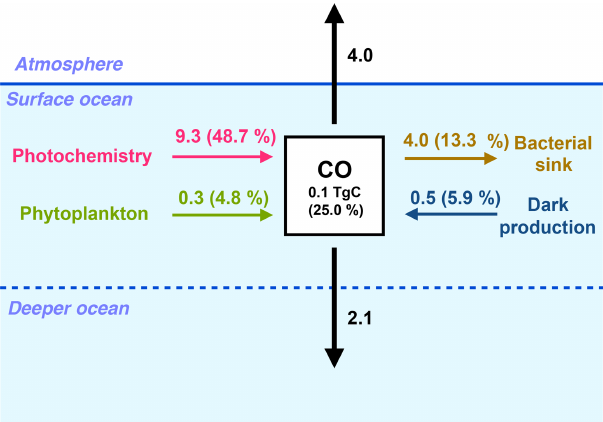
Figure 3. Global fluxes in the surface ocean (between 0 and 10m) of the oceanic CO sources and sinks (in TgCyr − 1 ). For each biogeo- chemical term (photoproduction, direct phytoplankton production, dark production and bacterial consumption), the relative contribu- tion of the surface layer to the whole water column budget is shown as a